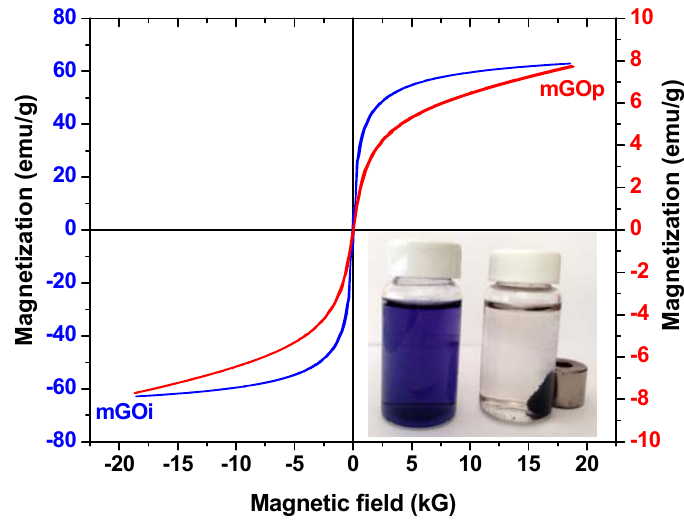
Figure 6. VSM plot of mGOi and mGOp (Inset: photo of mGOp).